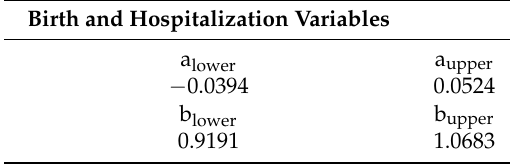
Table A4. Slope and intercept values for the statistical test of the IP ANN model at birth and during